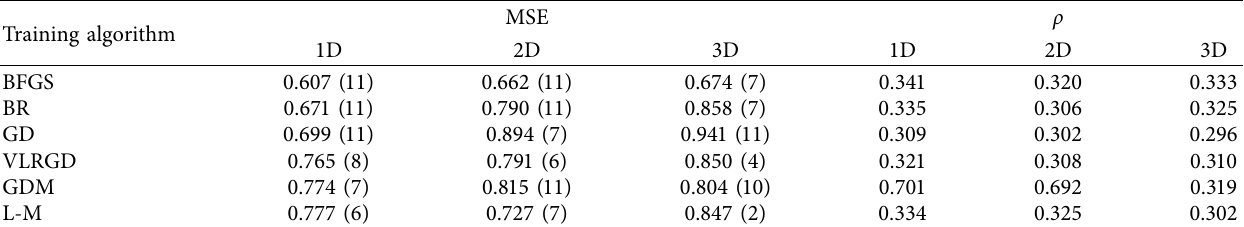
Table 3: Best RNN models identified in the validation stage with 1, 2, and 3 delays.